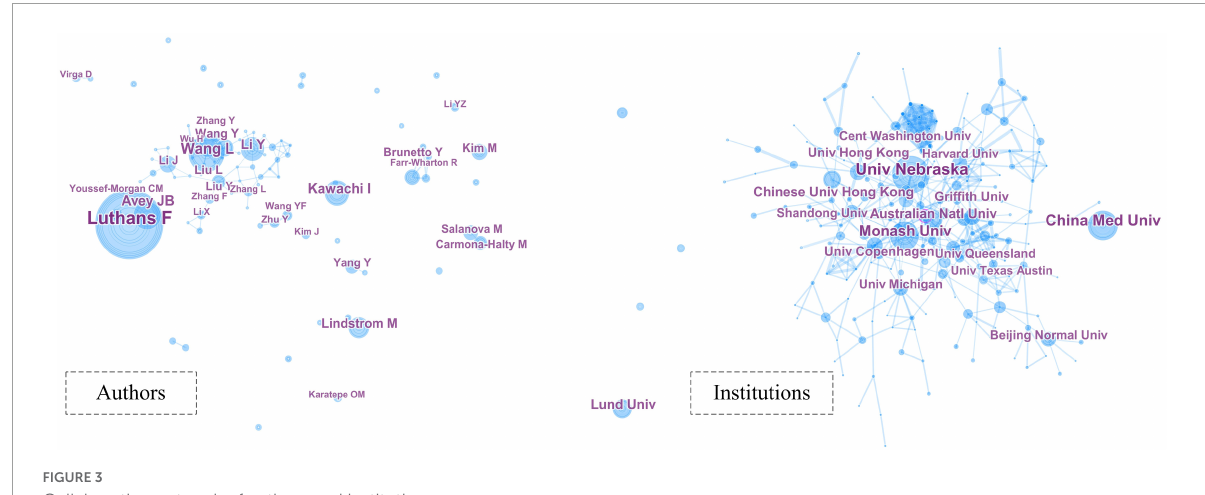
FIGURE3 Collaboration network of authors and institutions.